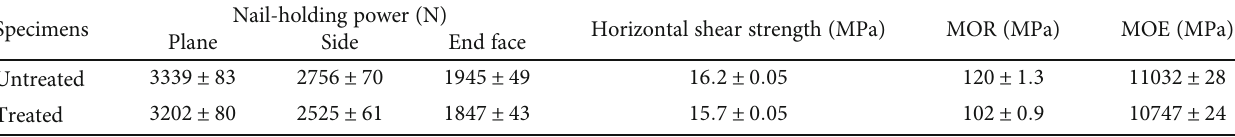
Table 3: Results of the bamboo scrimber ’ s mechanical properties after the wet circulation treatment ( mean ± standard deviation ). Nail-holding power (N) Cycle Horizontal shear strength (MPa) MOR (MPa) MOE (MPa) Plane Side End face Untreated 3339 ± 180 First cycle Third